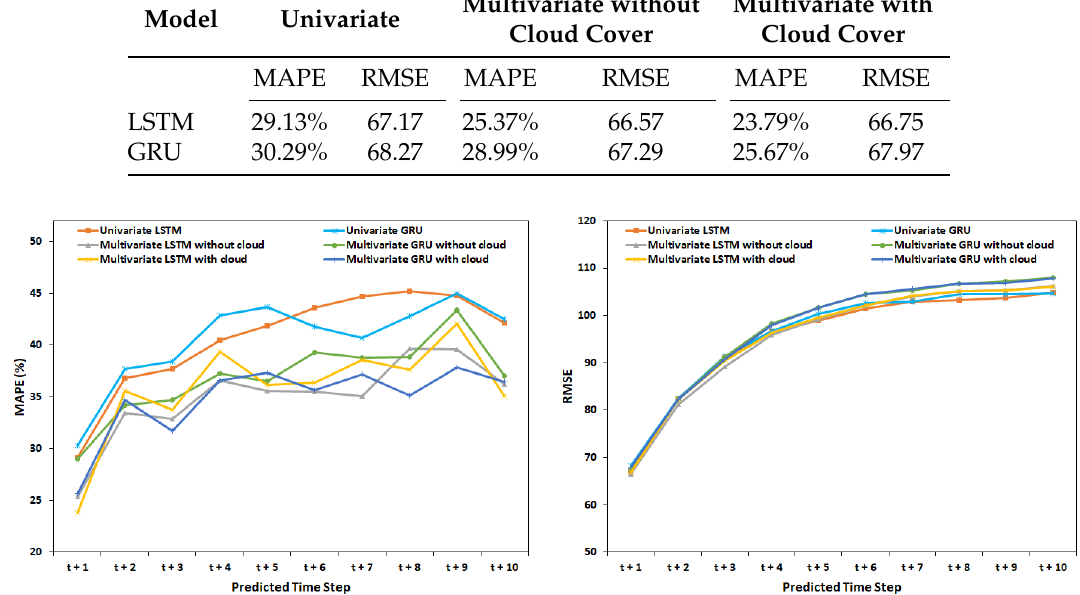
Figure 3. Mean Absolute Percentage Error (MAPE) and Root Mean Squared Error (RMSE) values for each model predicted ten time steps into the